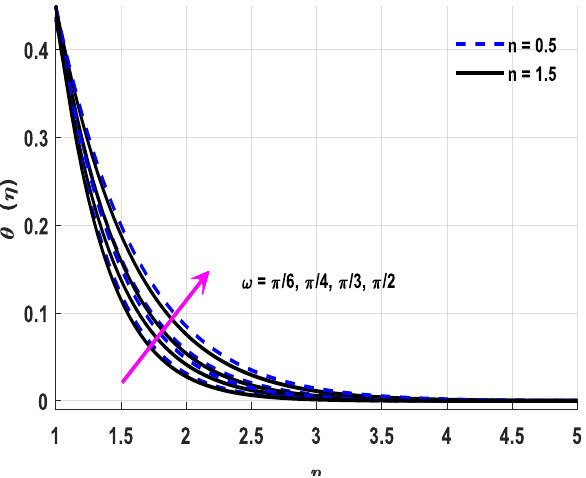
Figure 7. Variations in temperature profiles owing to changes in ω .